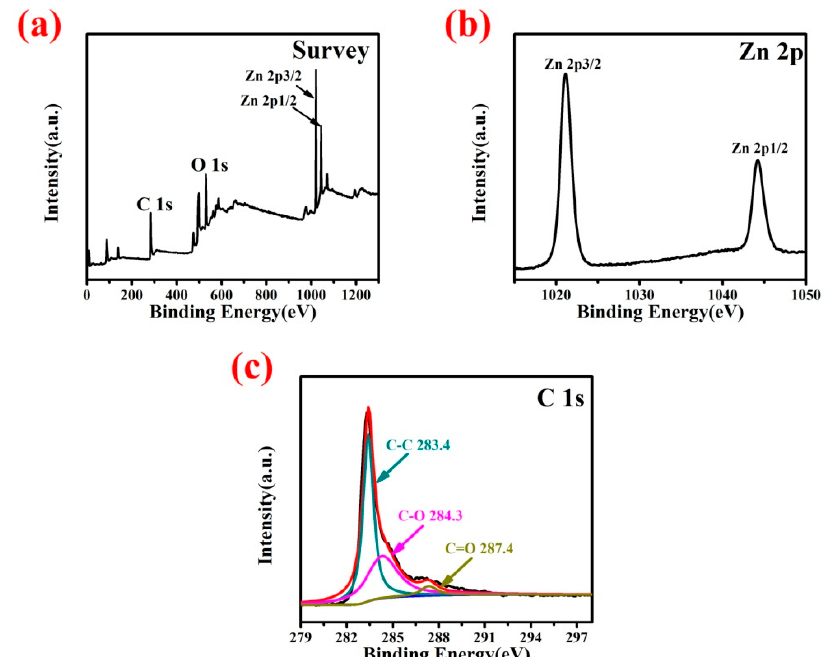
Figure 7. ( a ) Survey, ( b ) Zn 2p and ( c ) C 1s spectra of ZnO/graphene composites.